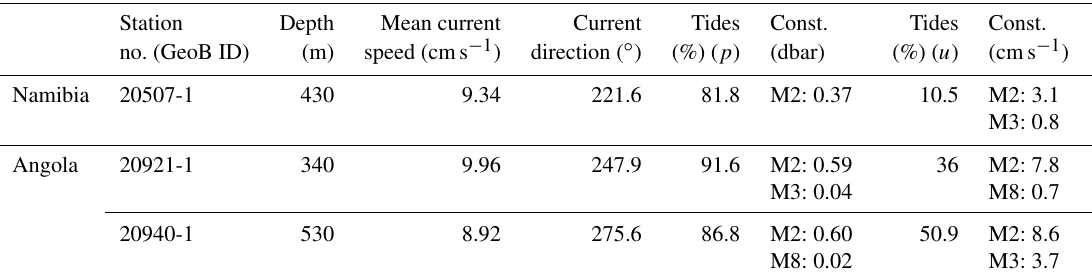
Table 3. Tidal analysis of the ALBEX lander from 6m above the sea floor. Depth, mean current speed, mean current direction, tidal prediction of pressure fluctuations, two most important harmonics with amplitude, tidal prediction of horizontal current field, two most important harmonics with semi-major axes’